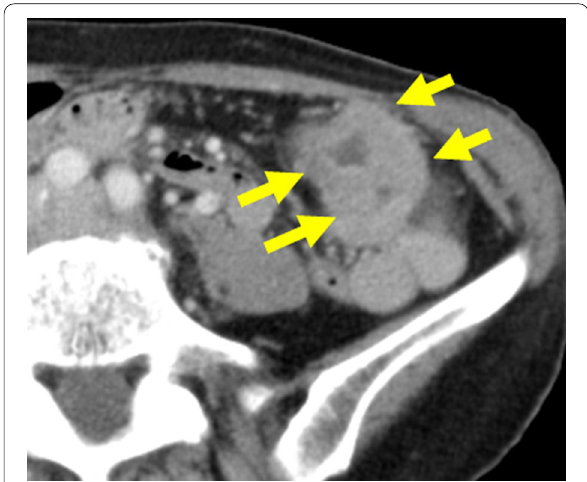
Fig. 2 Contrast-enhanced abdominal computed tomographic scan showing sub-circular wall thickening of the transverse colon near the splenic flexure (yellow